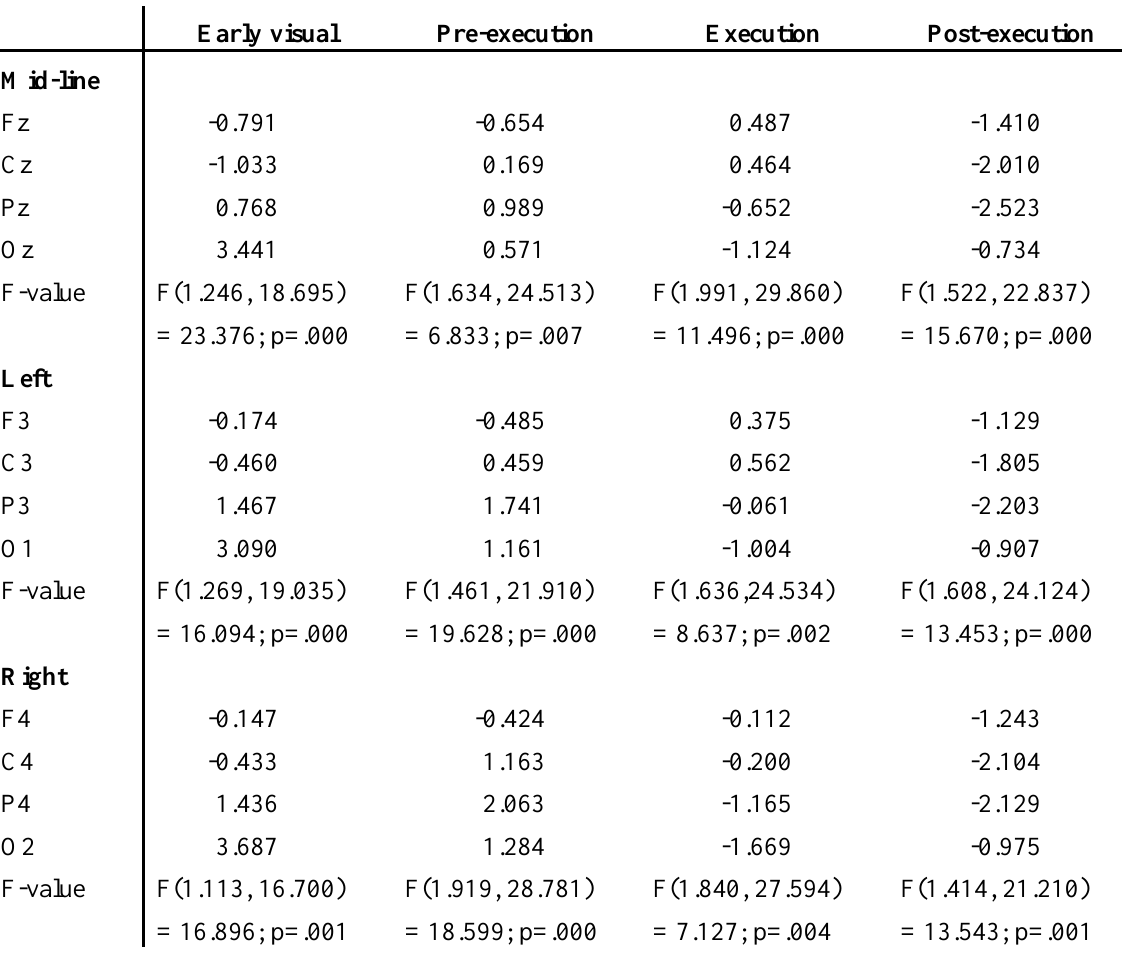
Table 1. The one way repeated measures ANOVAs were used to compare the mean amplitudes among anterior posterior electrodes in different phases over midline, left and right scalp locations.